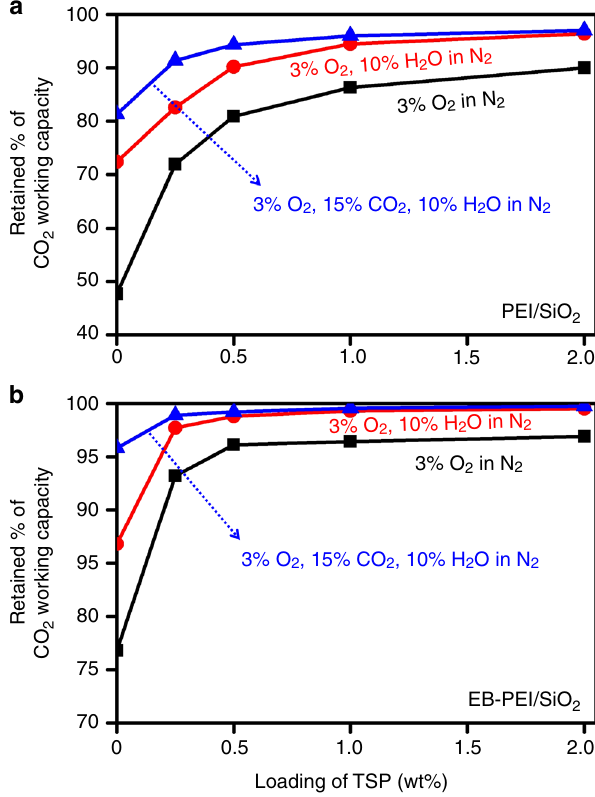
Fig. 4 Effects of gas compositions on the oxidative degradation of adsorbents. a , b Retained CO 2 working capacity (%) of PEI/SiO 2 ( a ) and EB-PEI/SiO 2 ( b ) containing different contents of trisodiumphosphate